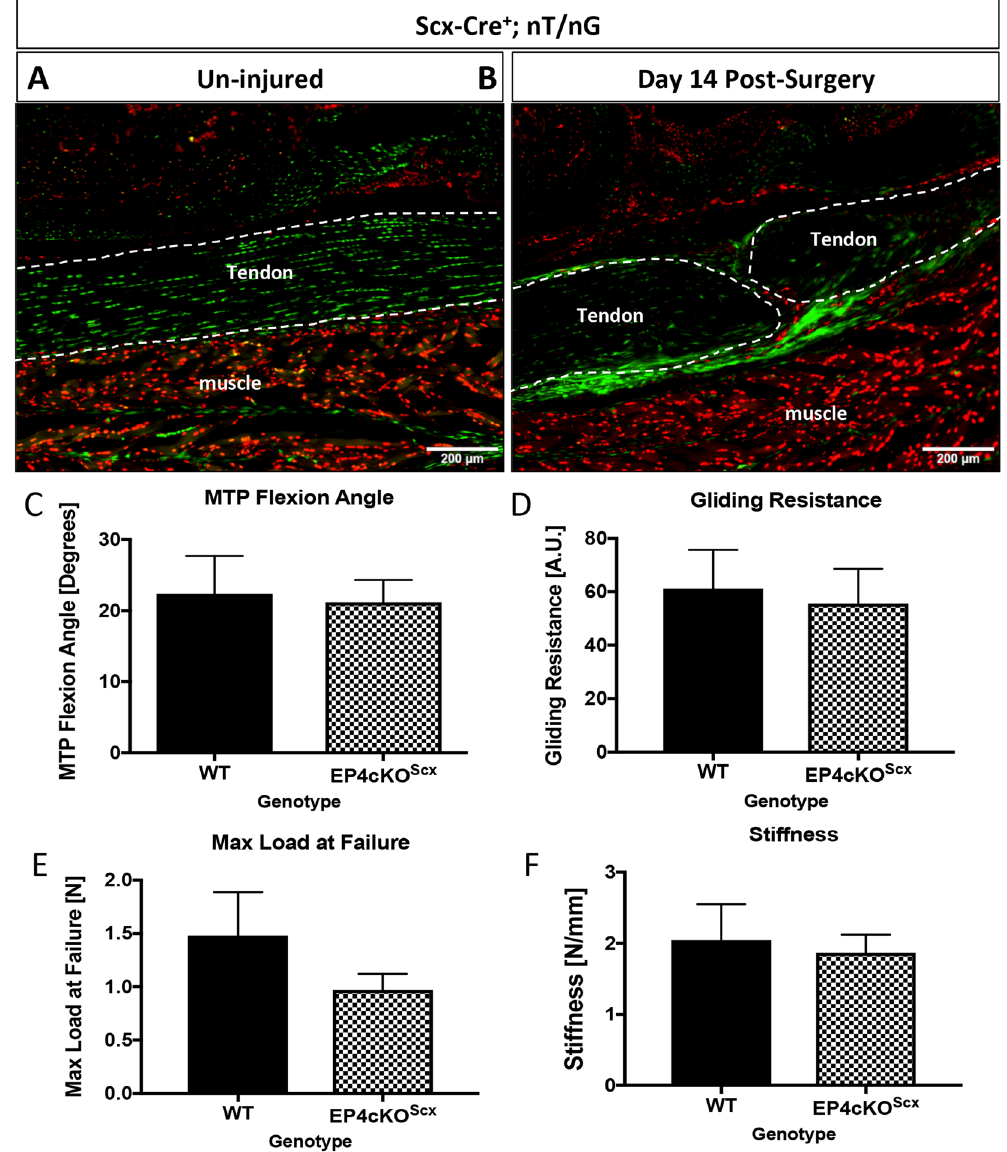
Figure 6. EP4cKO Scx does not alter tendon healing. ( A , B ) Tracing of Scx -lineage cells using Scx -Cre; nT/nG demonstrates that Scx -lineage cells are present in the un-injured tendon ( A ), and the repaired tendon at day 14 post-surgery ( B ). Scale bar represents 100 microns. ( C – F ) Repaired tendons from EP4cKO Scx and WT mice were harvested at day 14 post-surgery. No changes in ( C ) MTP Flexion Angle, ( D ) Gliding Resistance, ( E ) Max load at failure, ( F ) Stiffness were observed between WT repairs and EP4cKO Scx repairs. For tensile testing, all repaired tendons failed at the suture